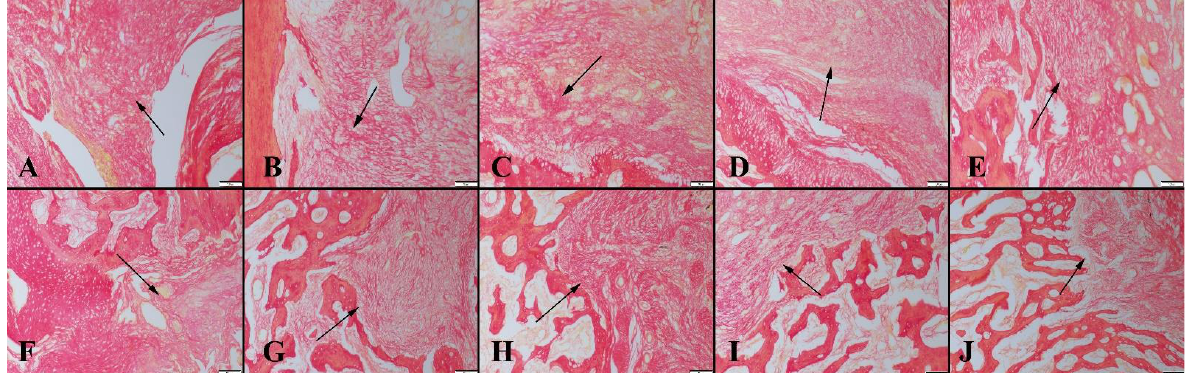
Figure 8. Micrographs showing fibrous tissue formation (arrows) in animal groups obtained via the Picro-Sirius red method. ( A ) Control group, ( B ) Group 1, ( C ) Group 2, ( D ) Group 3 and ( E ) Group 4, for 4-week and ( F ) Control group, ( G ) Group 1, ( H ) Group 2, ( I ) Group 3 and ( J ) Group 4, for 8-week. Decreased fibrous tissue formation is shown in graphene-coated scaffold-implanted groups, scale bar = 100 µ m. Table 1. Statistical analysis of histomorphic data.